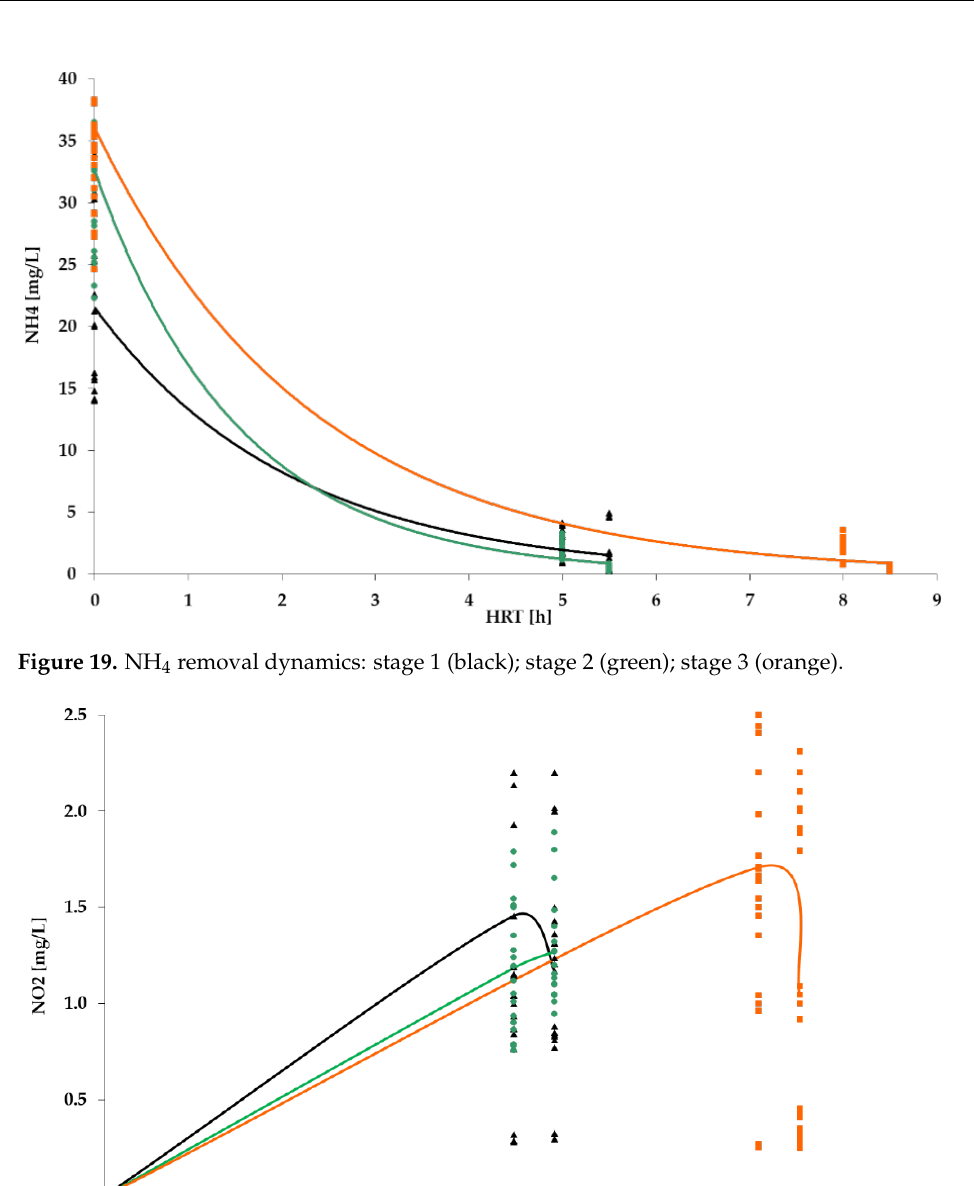
Figure 21. NO 3 dynamics: stage 1 (black); stage 2 (green); stage 3 (orange). Figures 20 and 21 illustrate the removal of organic pollutants and ammonium nitro- gen, which are similar to the removal levels observed in stage 2. Therefore, the treatment process may be considered stable under various values of HRT. It should be pointed out that within the current research, higher efficiency was achieved with higher values of pol- lutants, which was also revealed by Chu and Wang in their research [38]. An obvious drop in the concentration of NO 2 (see Figure 20) and a rise in the concentration of NO 3 (see figures) in the stage 3 indicates better nitrification/denitrification conditions and intensity in the system, which resulted from both the redirected RAS flow and the higher value of HRT. This also speaks in favor of improved stability in the treatment process compared with the results in stages 1 and 2. As can be seen from Table 3, in stage 3, the removal of BOD 5 and NH 4 remained at a consistently high level, and the absolute values of these indicators in the effluent met the required standards. Attention is drawn to the fact that the MLSS value for free-floating sludge in the system was significantly lower compared with stage 2, but this did not affect